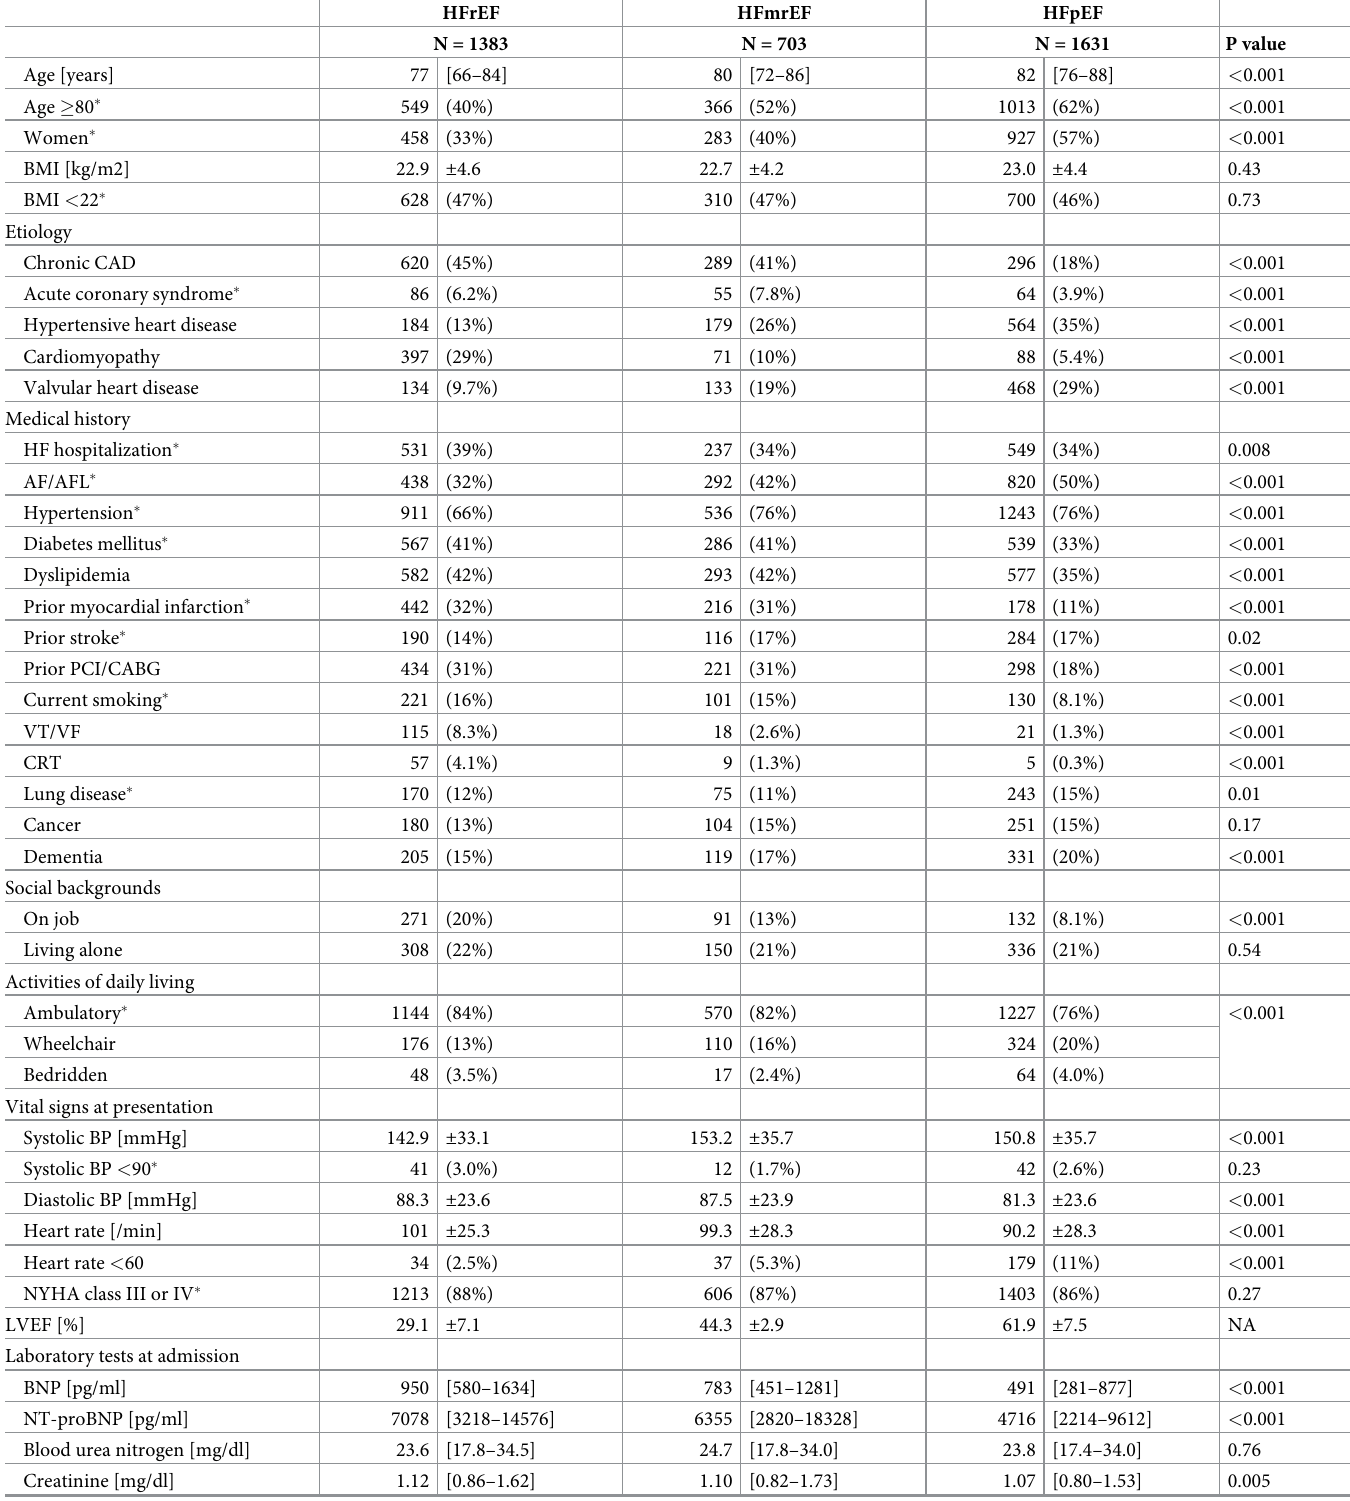
Table 1. Baseline patient characteristics stratified by the LVEF